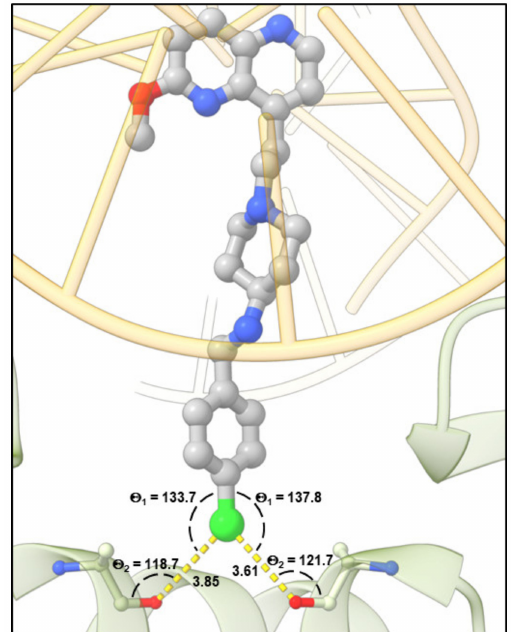
Figure 4. Symmetrical bifurcated halogen-bonding of compound 13 in complex with S. aureus DNA gyrase and DNA molecule (PDB ID: 6Z1A) [13]. GyrA subunit is shown in green, compound 13 is colored in grey (ball and sticks representation) and DNA in pale orange. Halogen bonds are represented as yellow